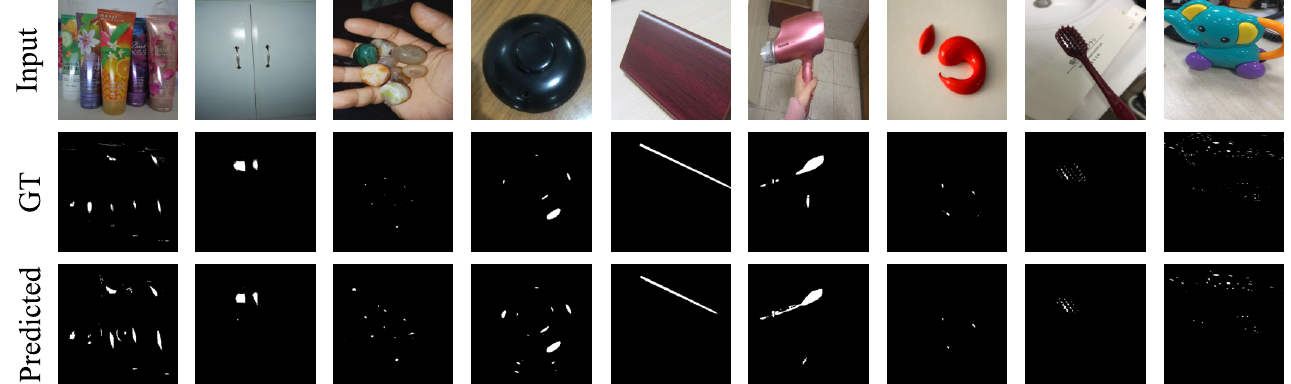
Figure 5. Segmentation results of SpecSeg network as compared to manually labelled ground truths in the Whu-Specular dataset [57].